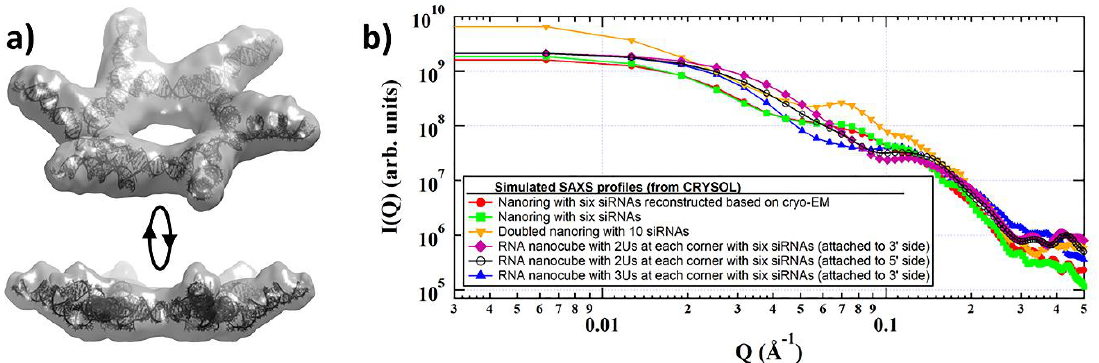
Figure 5. ( a ) Cryogenic-electron microscopy (cryo-EM) reconstruction of RNA nanoring functionalized with six short interfering RNAs (siRNAs) and ( b ) its calculated SAXS profile (red circles) compared to the calculated SAXS profile for other predicted NA nanoparticle structures. Profiles were calculated from models based on cryo-EM pdb files using the program CRYSOL [71].